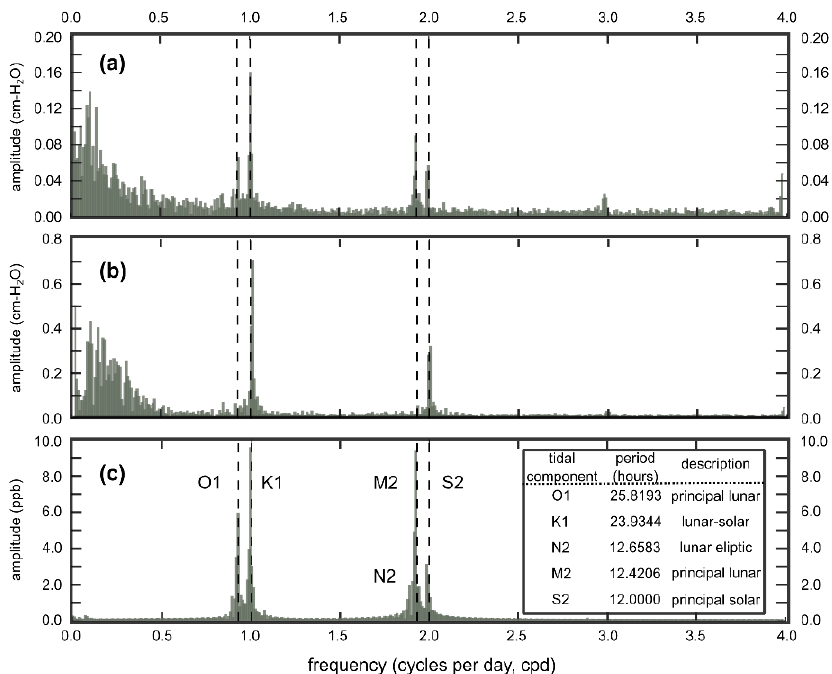
Figure 3. ( a ) Discrete amplitude spectra for Fourier transform of water level in well PZ-01; ( b ) discrete